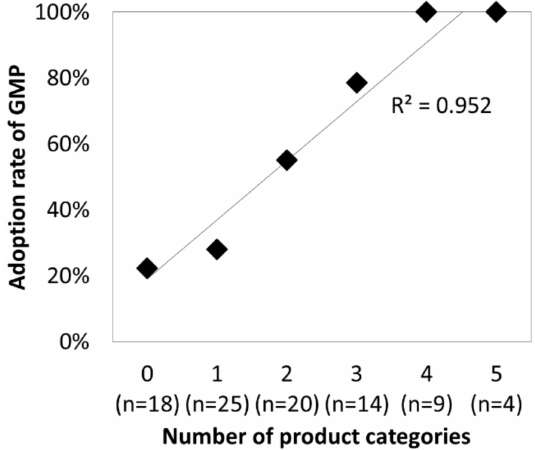
Figure 5. Relationship between the number of product categories and adoption rate of GMP.